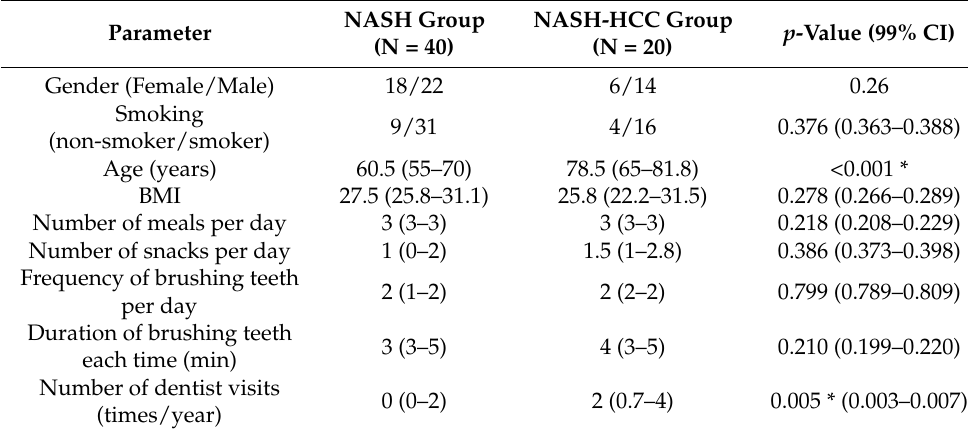
Table 1. Participant information and lifestyle